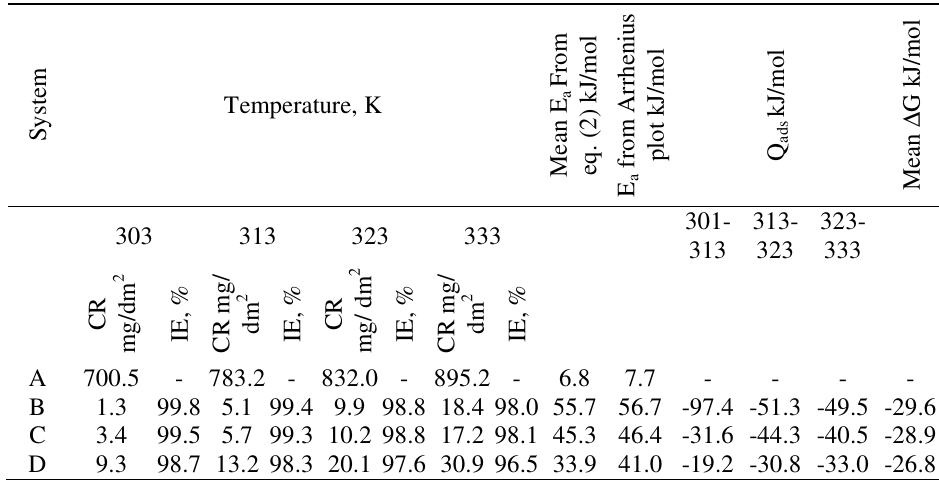
Table 2. Effect of temperature on Corrosion rate (CR), Inhibition efficiency (IE%) for zinc